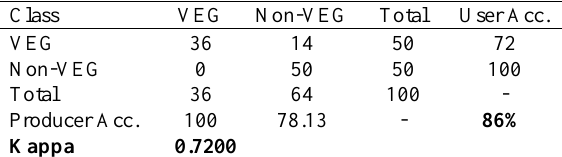
Table 10. Error Matrix for the classified scene (172/43) of 1978